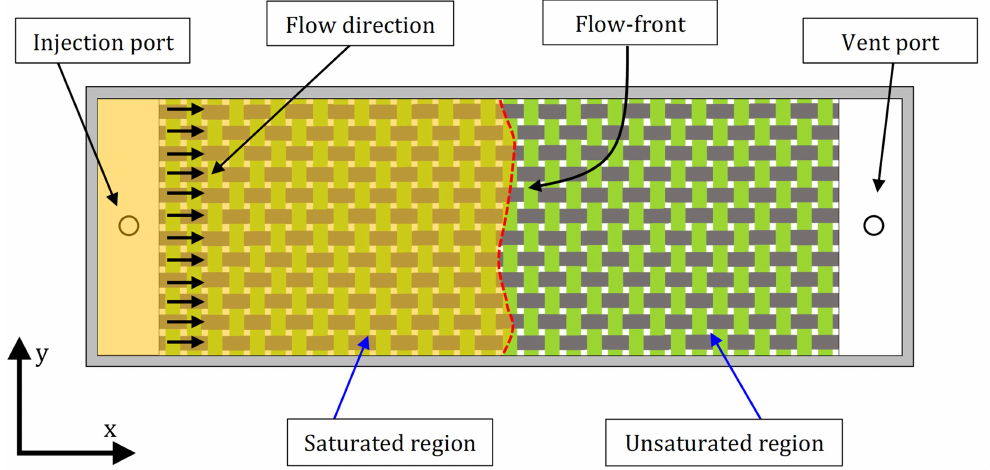
Figure 1. A schematic diagram illustrating mould-filling process parameters, saturation and unsatu- ration regions, and filling front advancement with uniform